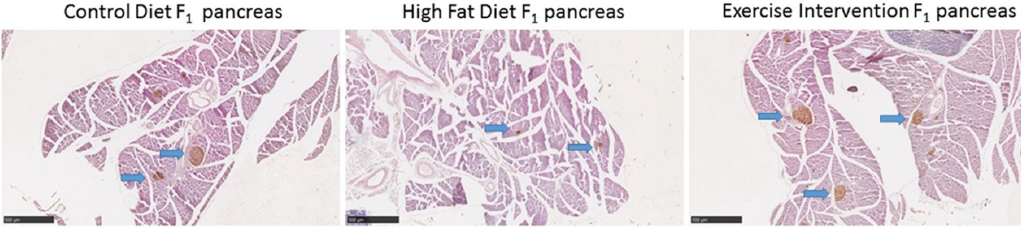
Figure 4. Effect of high fat diet fed founders with exercise interventions on male offspring pancreas morphology at 8 weeks. Representative pictures of pancreatic morphology and islet cell staining in male offspring. Images have been captured at 40x objective. Blue arrows are pointing to insulin positive cells (islet β cell clumps).